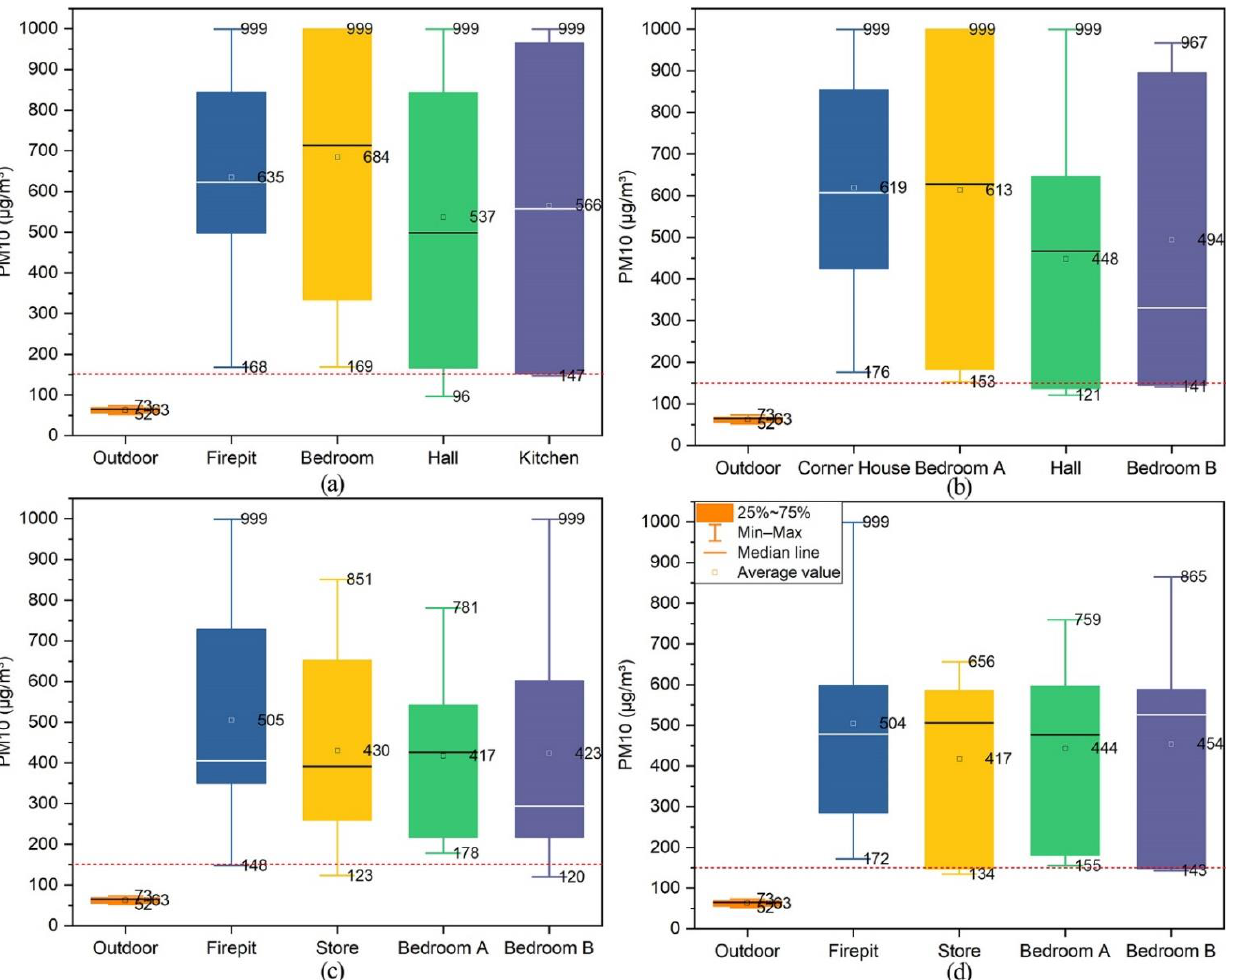
Figure 13. Analysis of PM 10 concentrations during indoor fires in ancient Tujia town dwellings. ( a ) Zuozi dwelling [34], ( b ) L-shape dwelling [34], ( c ) lower store and upper house dwelling, ( d ) front store and back house dwelling.